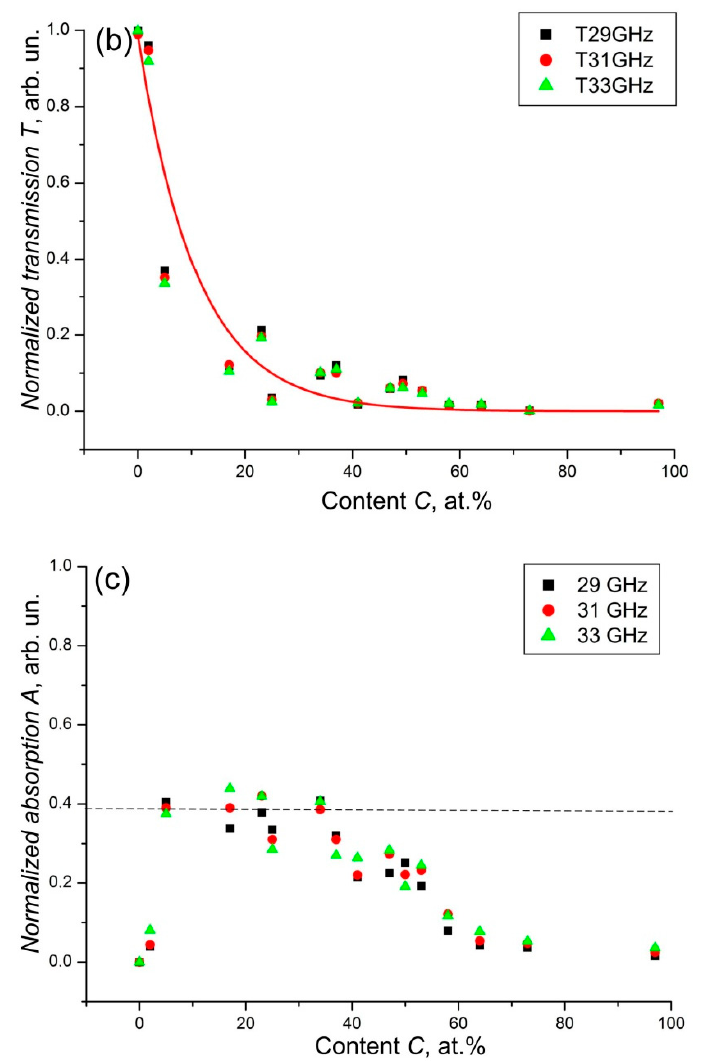
Figure 14. The dependence of the reflection ( a ), transmission ( b ), and absorption ( c ) of electromag- netic radiation on the carbon concentration of shungite plates in the frequency range 26–38 GHz. Approximation (red line in ( a , b )) is performed at a frequency of 31 GHz (from [80]).